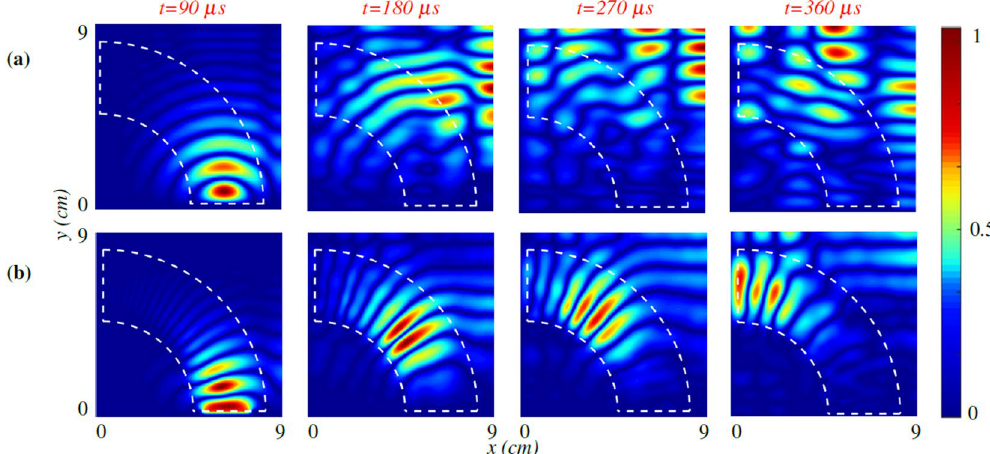
Figure 2. Numerical results. Numerically calculated wave response of the system at the frequency of 50 kHz . Waveguide’s boundary is shown with white dashed line where the boundaries are at r 1 = 5 cm and r 2 = 8.6 cm . (a) Constant thickness h = 1 mm , along the guiding trajectory different from host’s medium thickness. (b) Proposed thickness h ( r ) = 0.4 r 2 along the wave bending channel.